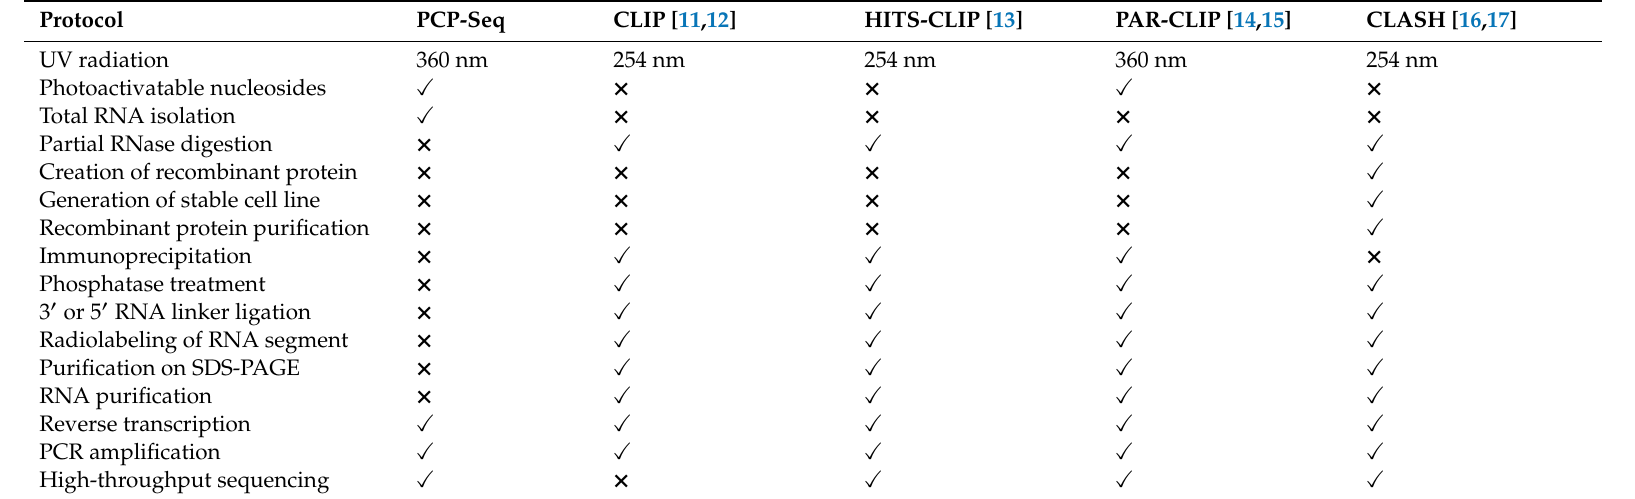
Table 1. Comparison of methodologies used in PCP-Seq strategy with previous CLIP-based